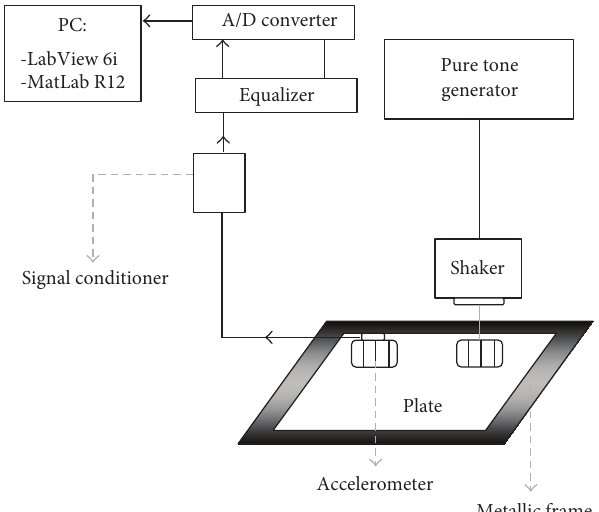
F 1: Experimental mounting of sample for vibration